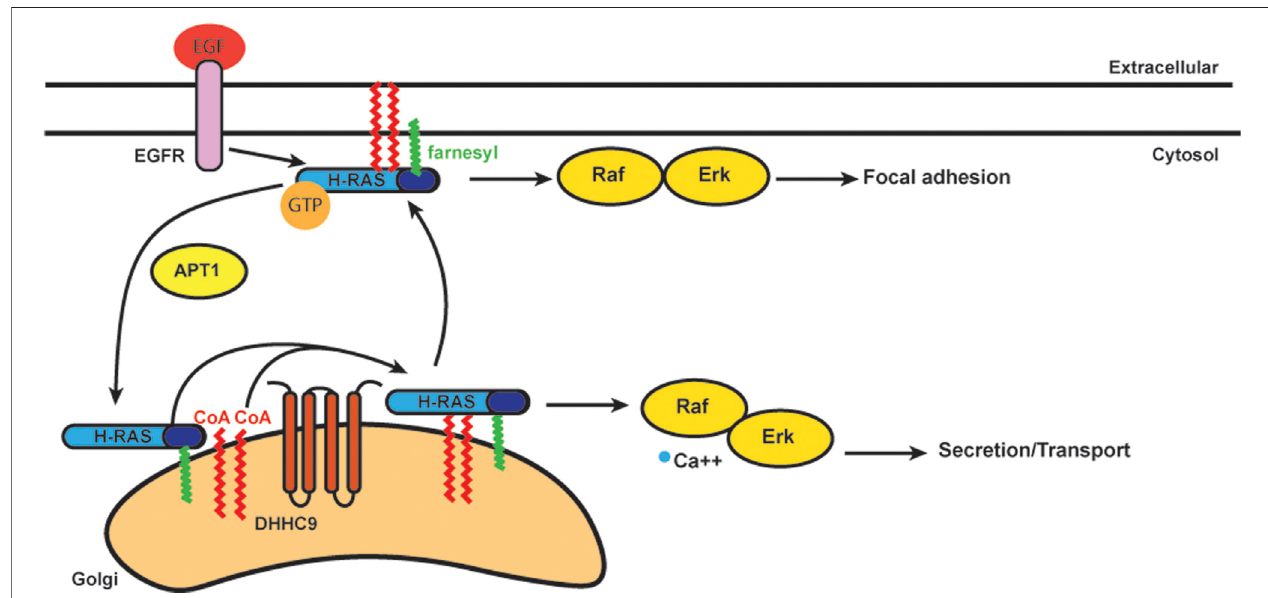
FIGURE 4 | Schematics of acylation/deacylation regulation of H-RAS localization and signaling. DHHC9 S-acylates H-RAS to stablize its localization on plasma membrance(PM)andactivatestheRaf-Erkpathway toregulatefocaladhesion.OncetheS-acylationisremovedbyAPT1,H-RASthatisonlyfarnesylateddoesnotbind PM and cycles to